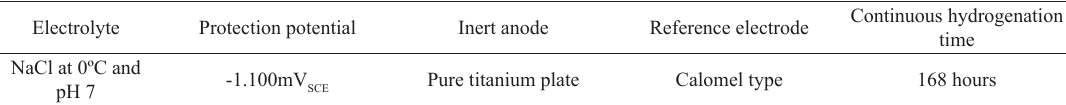
Table 8. Cathodic protection parameters.